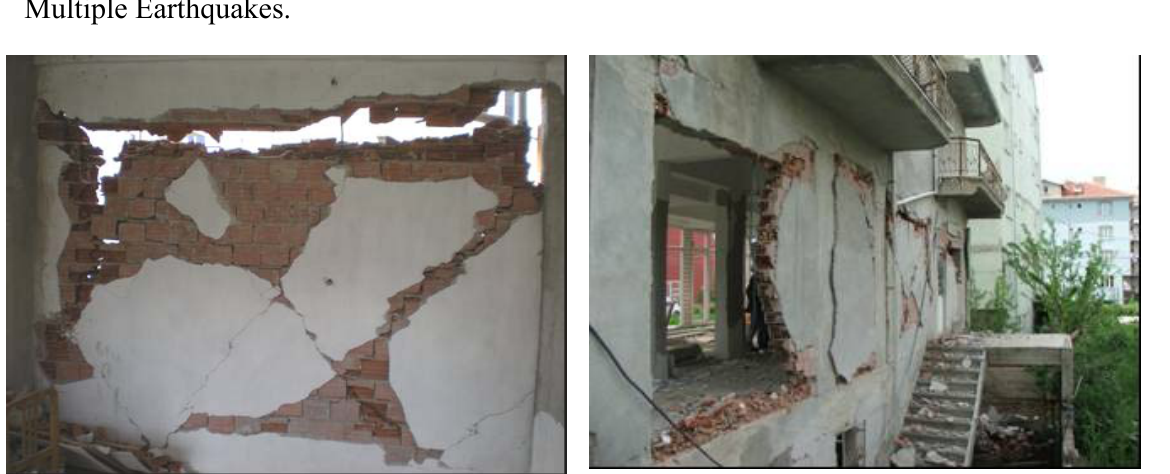
Figure 16. Infill wall damage in reinforced concrete buildings. Damage Caused by Multiple Earthquakes.